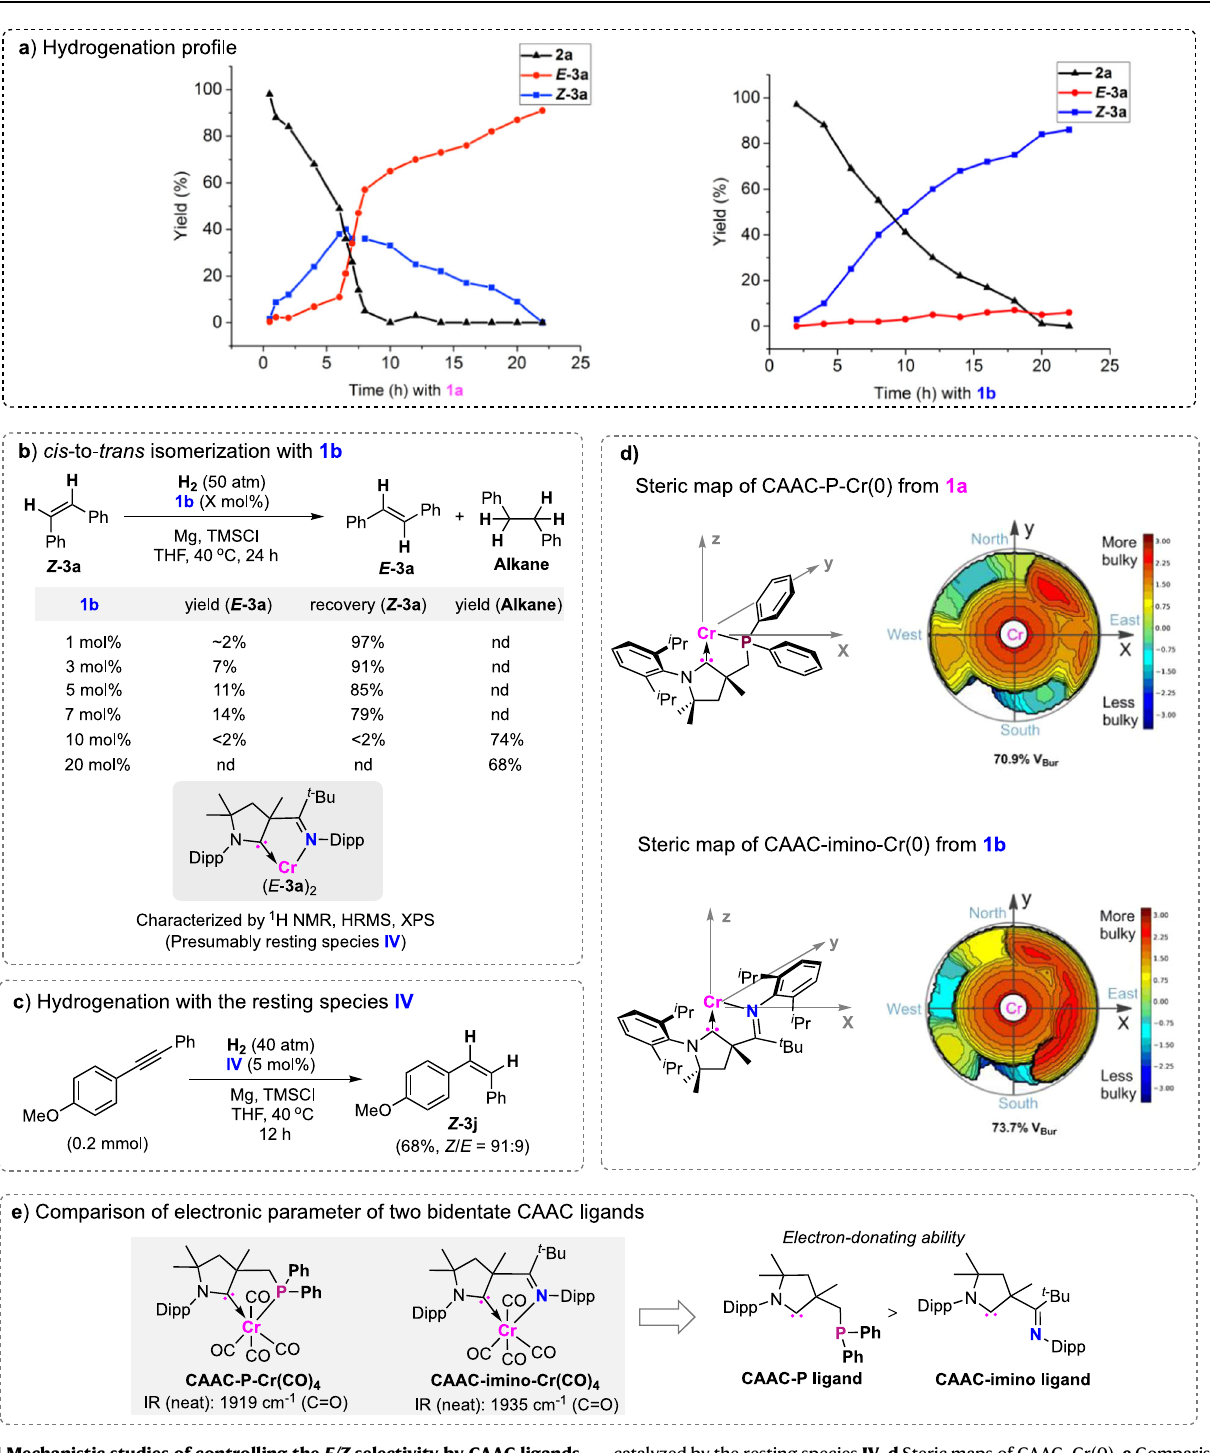
catalyzed by therestingspecies IV . d Stericmaps of CAAC – Cr(0). e Comparisonof electronic parameters of two bidentate CAAC